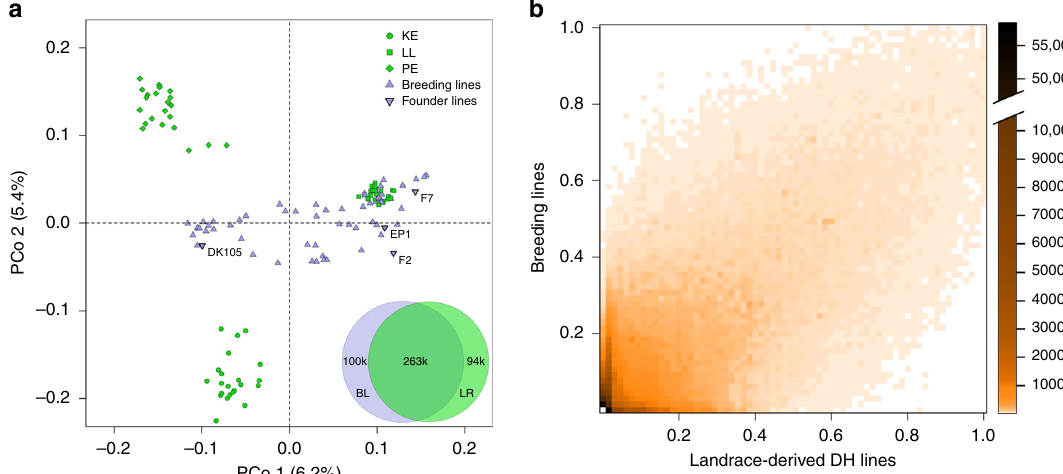
Fig. 1 Molecular inventories point to untapped variation in landraces. a Principal coordinate analysis based on pairwise modi fi ed Rogers ’ distances of 66 landrace-derived DH lines and 65 breeding lines (triangles), including four prominent founder lines (downward triangles). From each of three DH libraries, KE (circles), LL (squares), and PE (diamonds), 22 lines were sampled randomly. Axis labels show the percentage variance explained per principal coordinate. Venn diagram shows overlap of 456,911 haplotypes between 941 landrace-derived DH lines (LR) and 65 European breeding lines (BL). Haplotypes were constructed for nonoverlapping genomic windows of 10 SNPs. b Frequency of 456,911 haplotypes in DH lines ( x -axis) and breeding lines ( y -axis). Colors indicate the number of haplotypes within each cell of the heat map. Source data are provided as a Source data fi